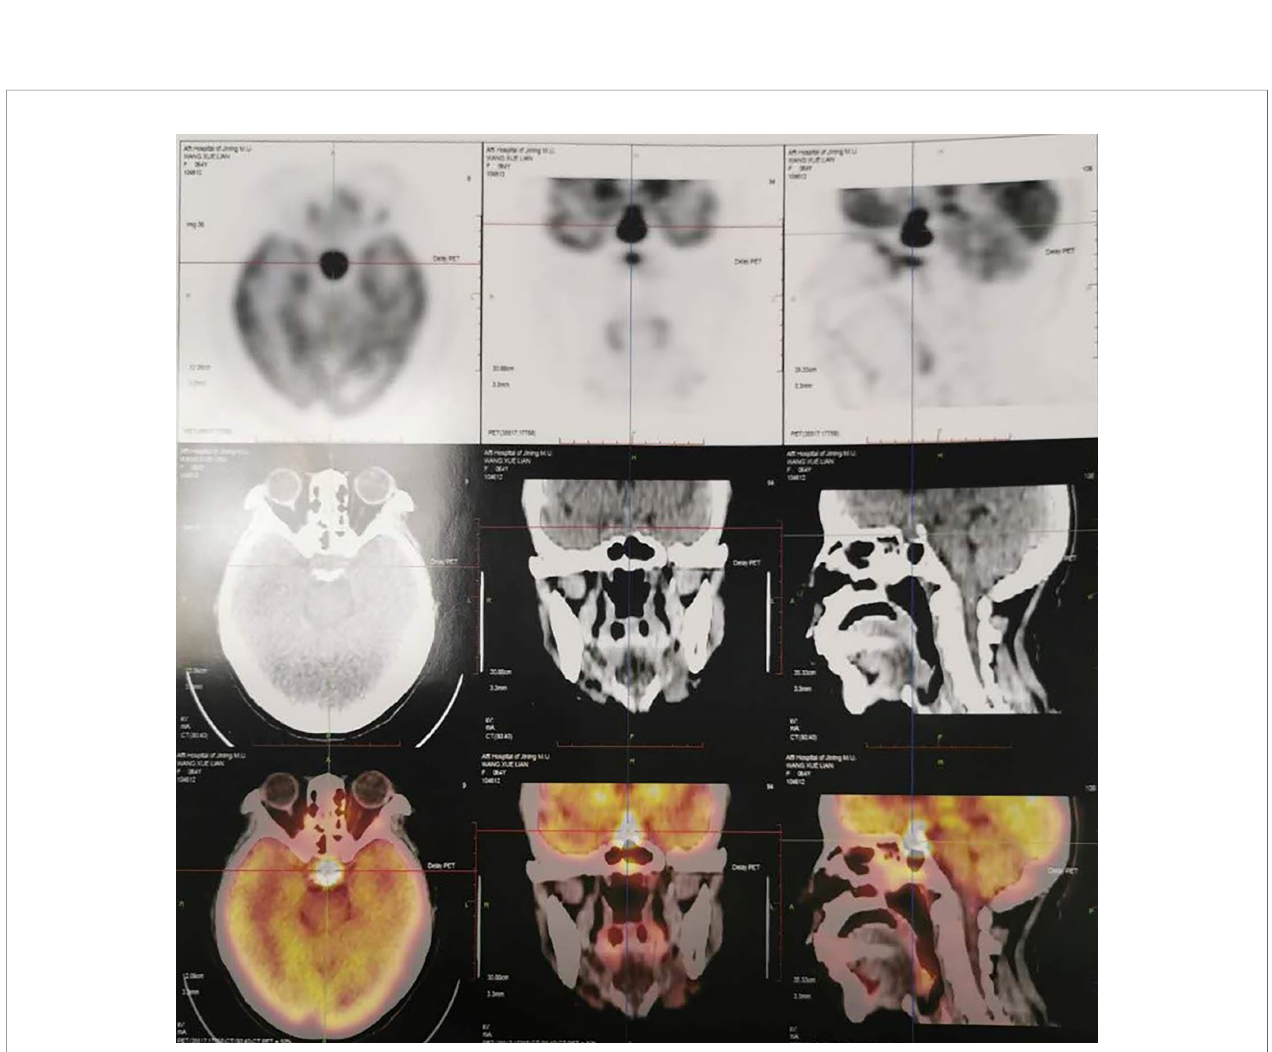
FIGURE 2 | PET-CT one month ago showed the mass (2.3 × 2.0 cm) in pituitary gland with increased FDG uptake and SUVmax of 75.7 in Case